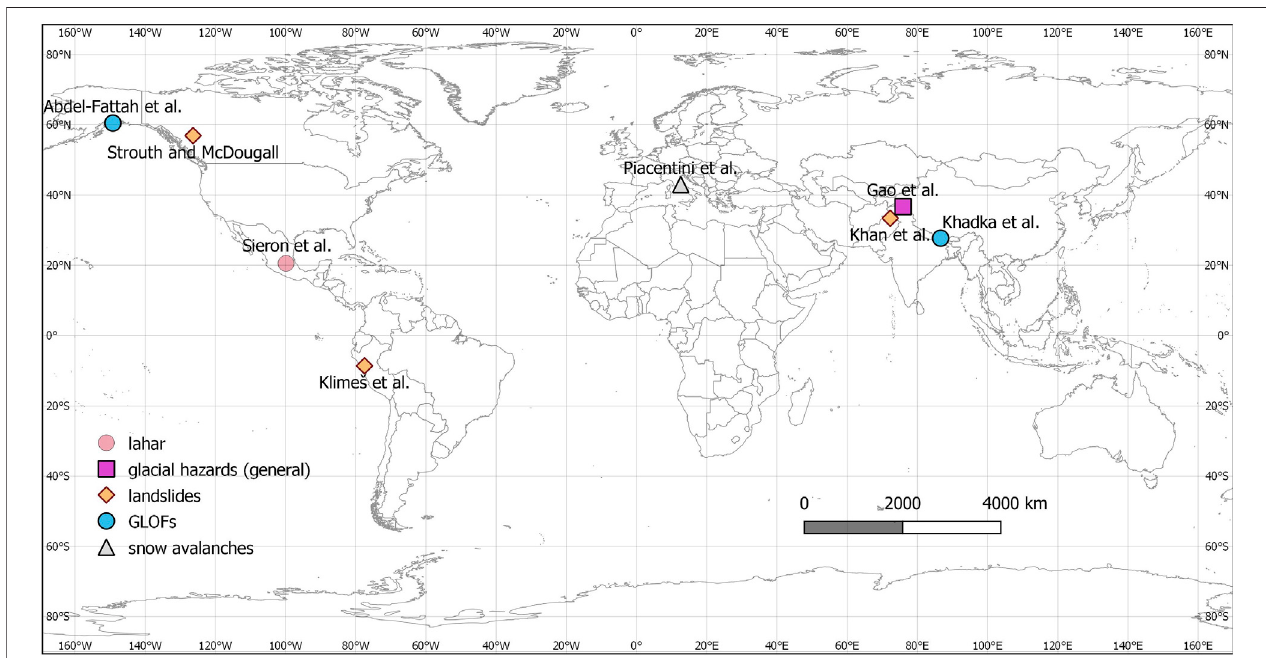
FIGURE 1 | Topical and geographical distribution of contributions in this Research Topic.